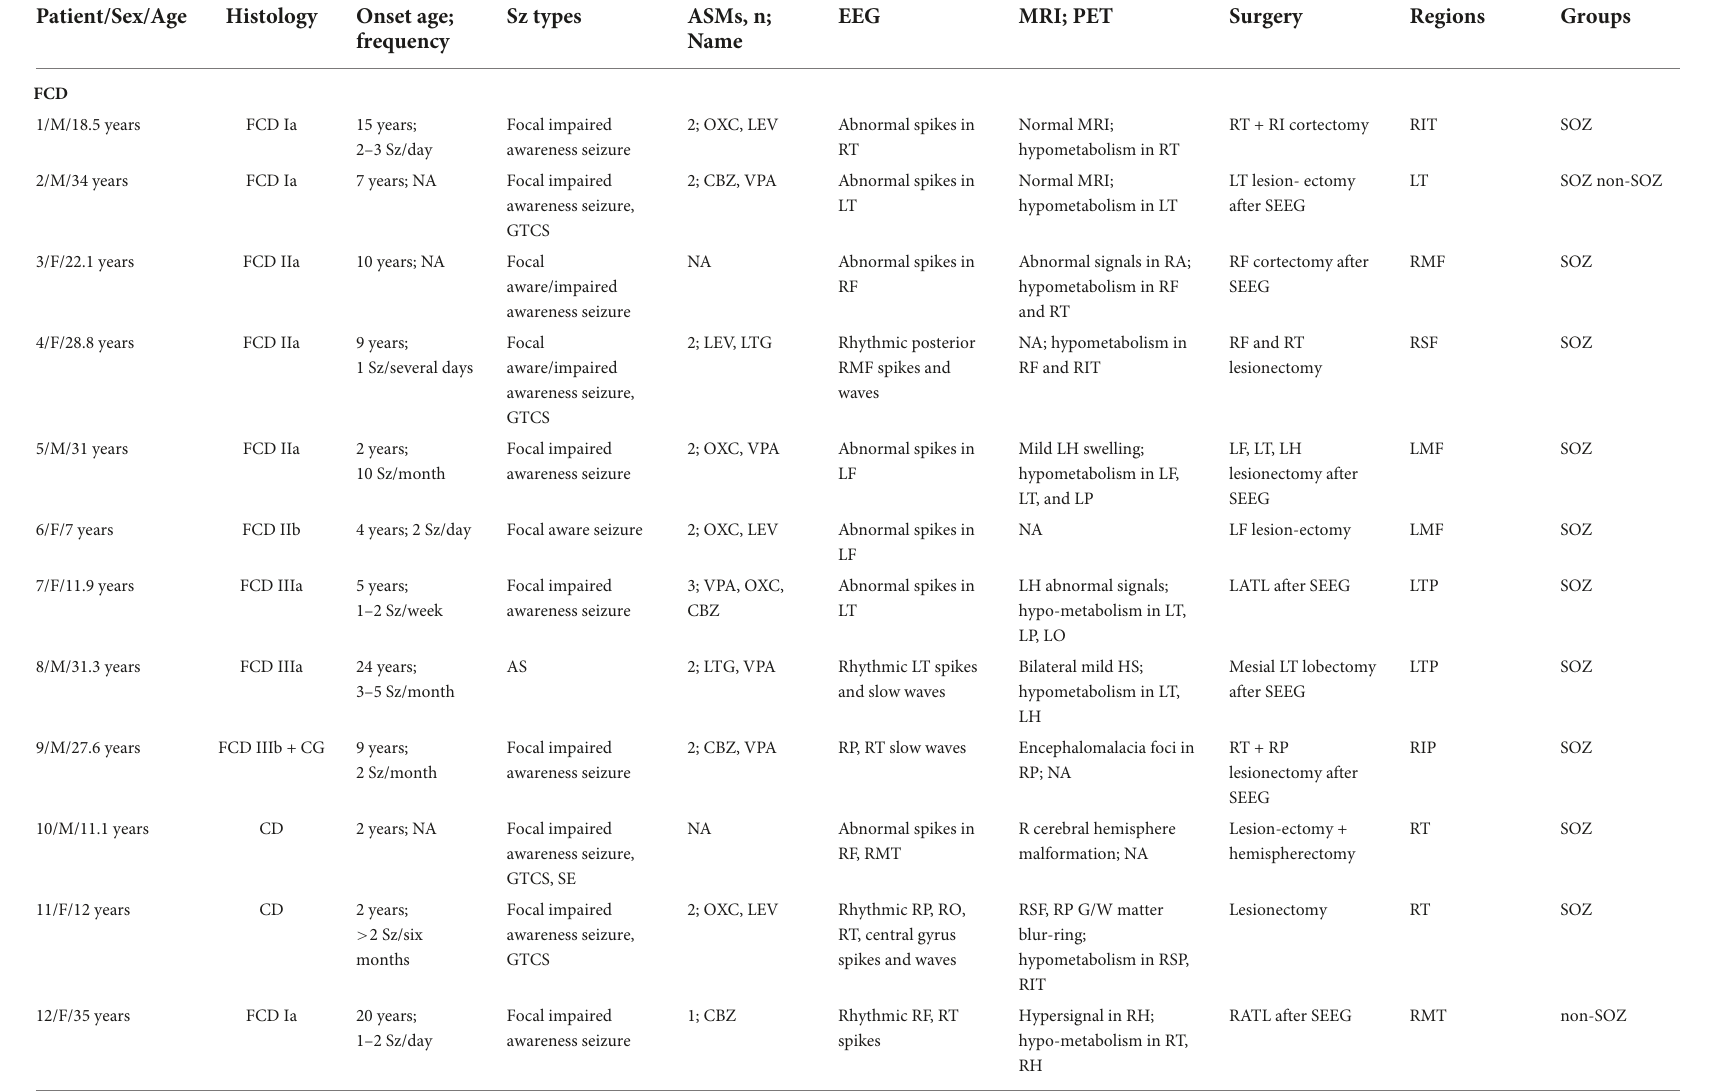
TABLE 1 Patients